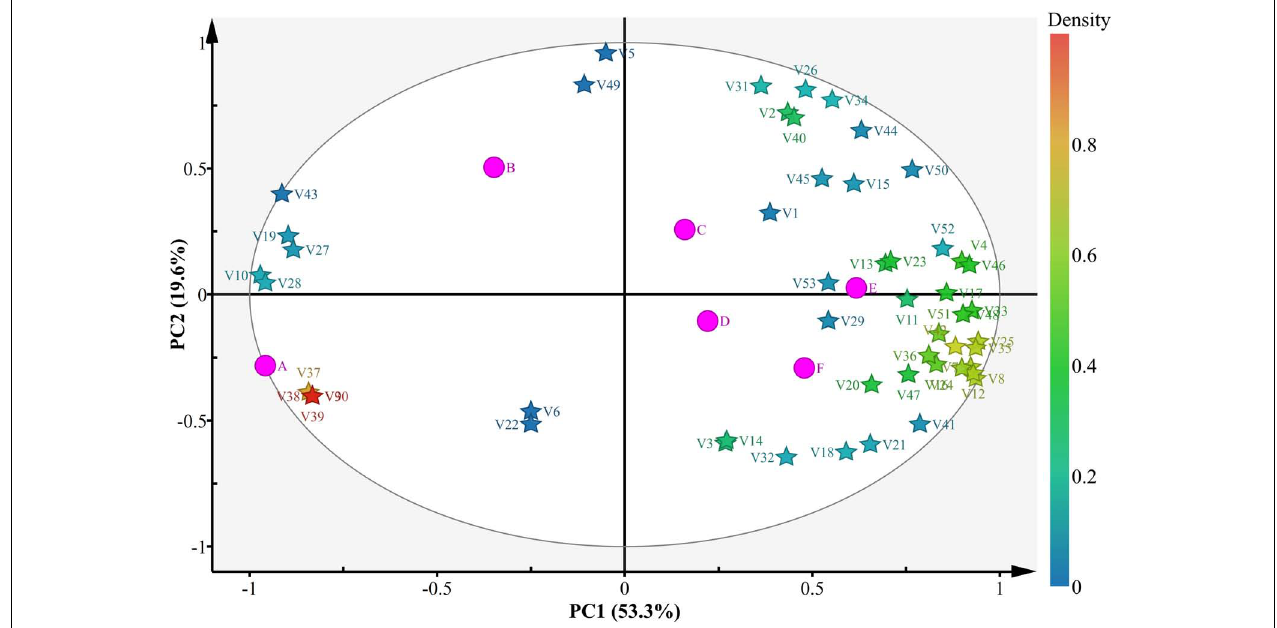
FIGURE 5 | Bioplot of the PCA for volatile compounds present in the samples. A, B, C, D, E, and F Represent samples collected on fermentation days 0, 3, 6, 9, 12, and 16, respectively. “V” represents volatile